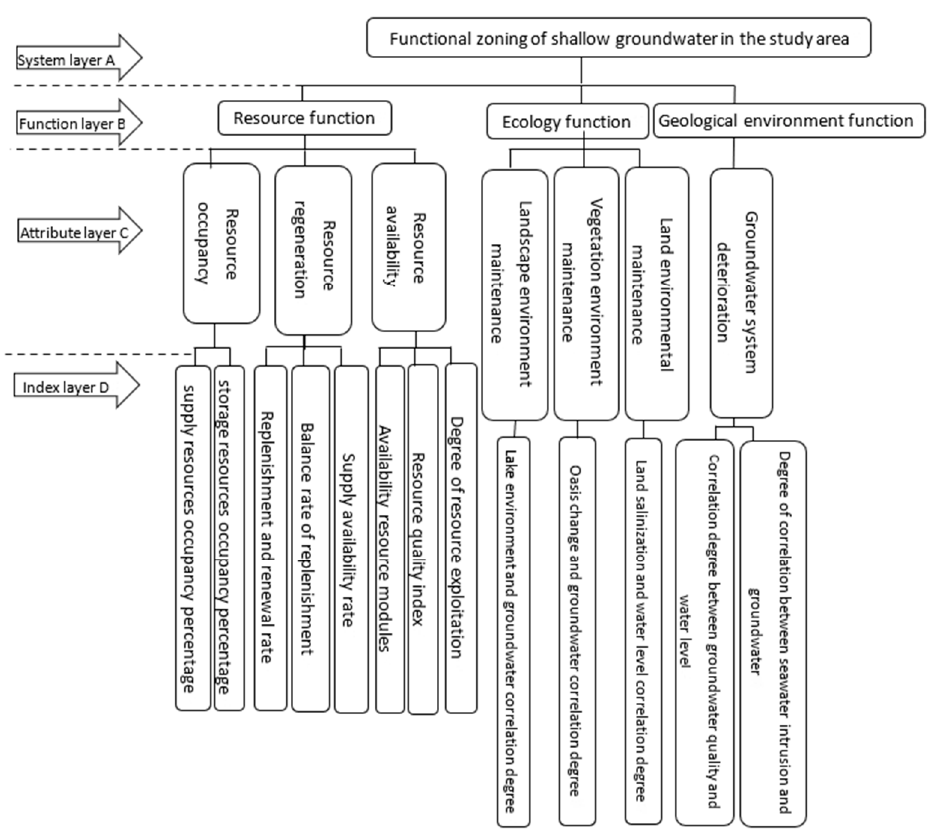
Figure 2. Functional zoning hierarchical structure of shallow groundwater in Pingtan Island.